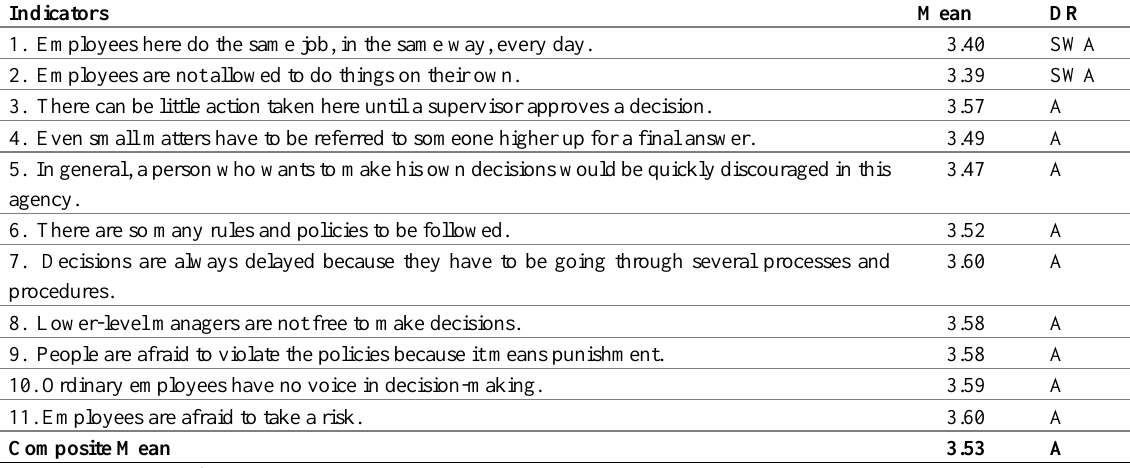
Table 1: The Bureaucratic Management of Divine Word Colleges in the Ilocos